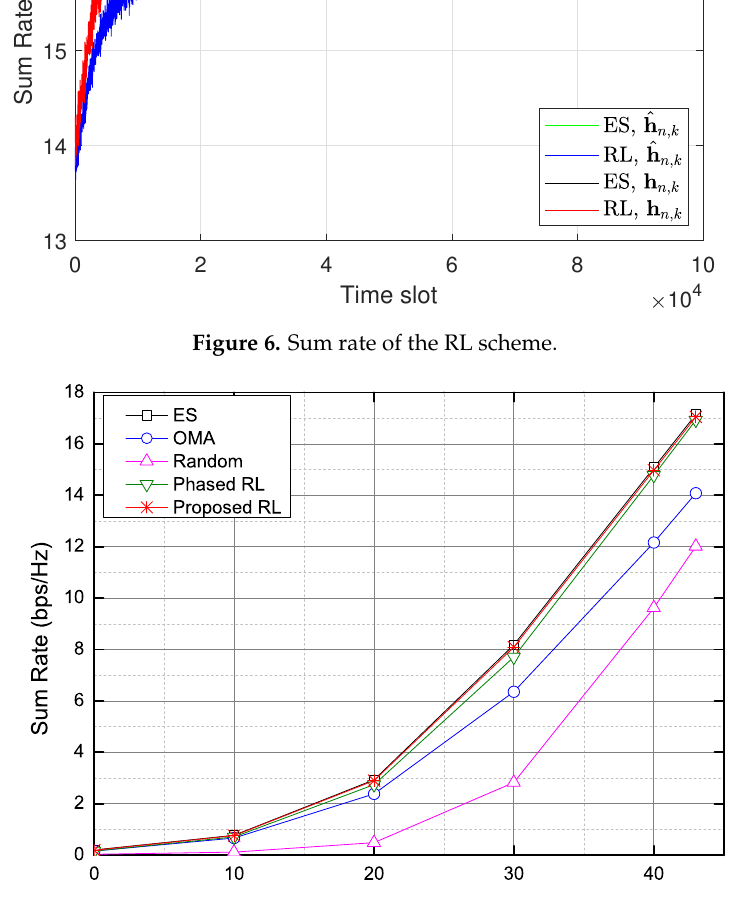
Figure 7. Sum rate versus transmit